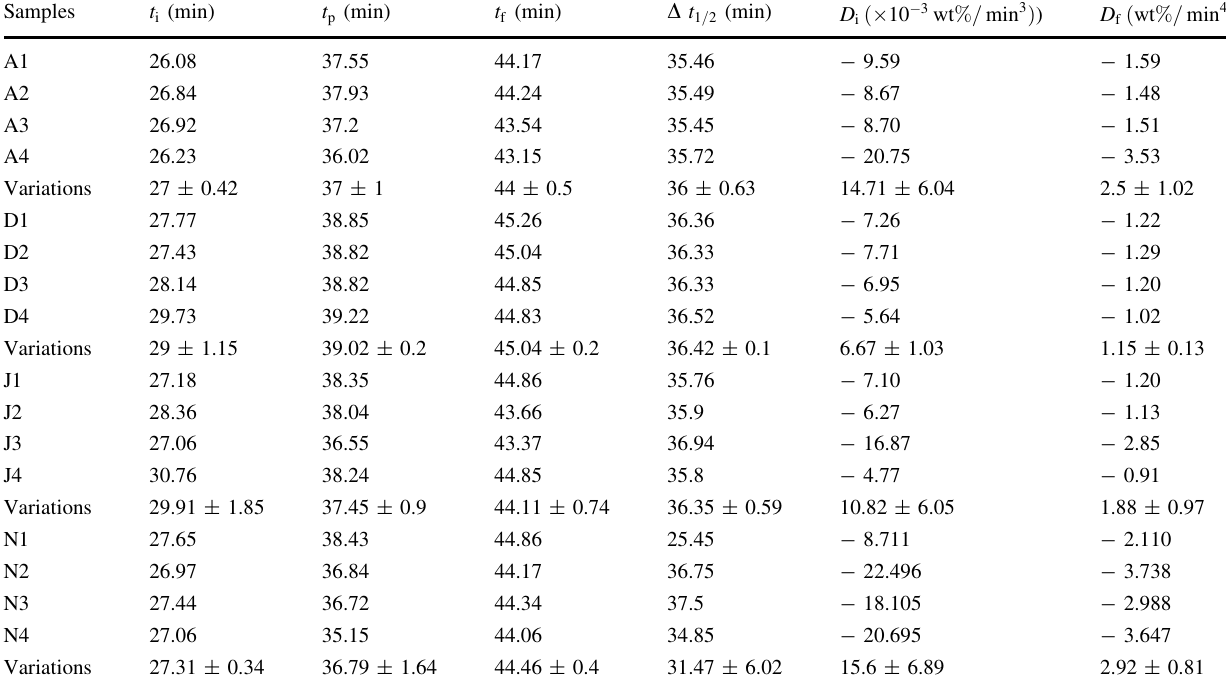
Table 3 Characteristic combustion parameters of different coal (A, D, J and N)